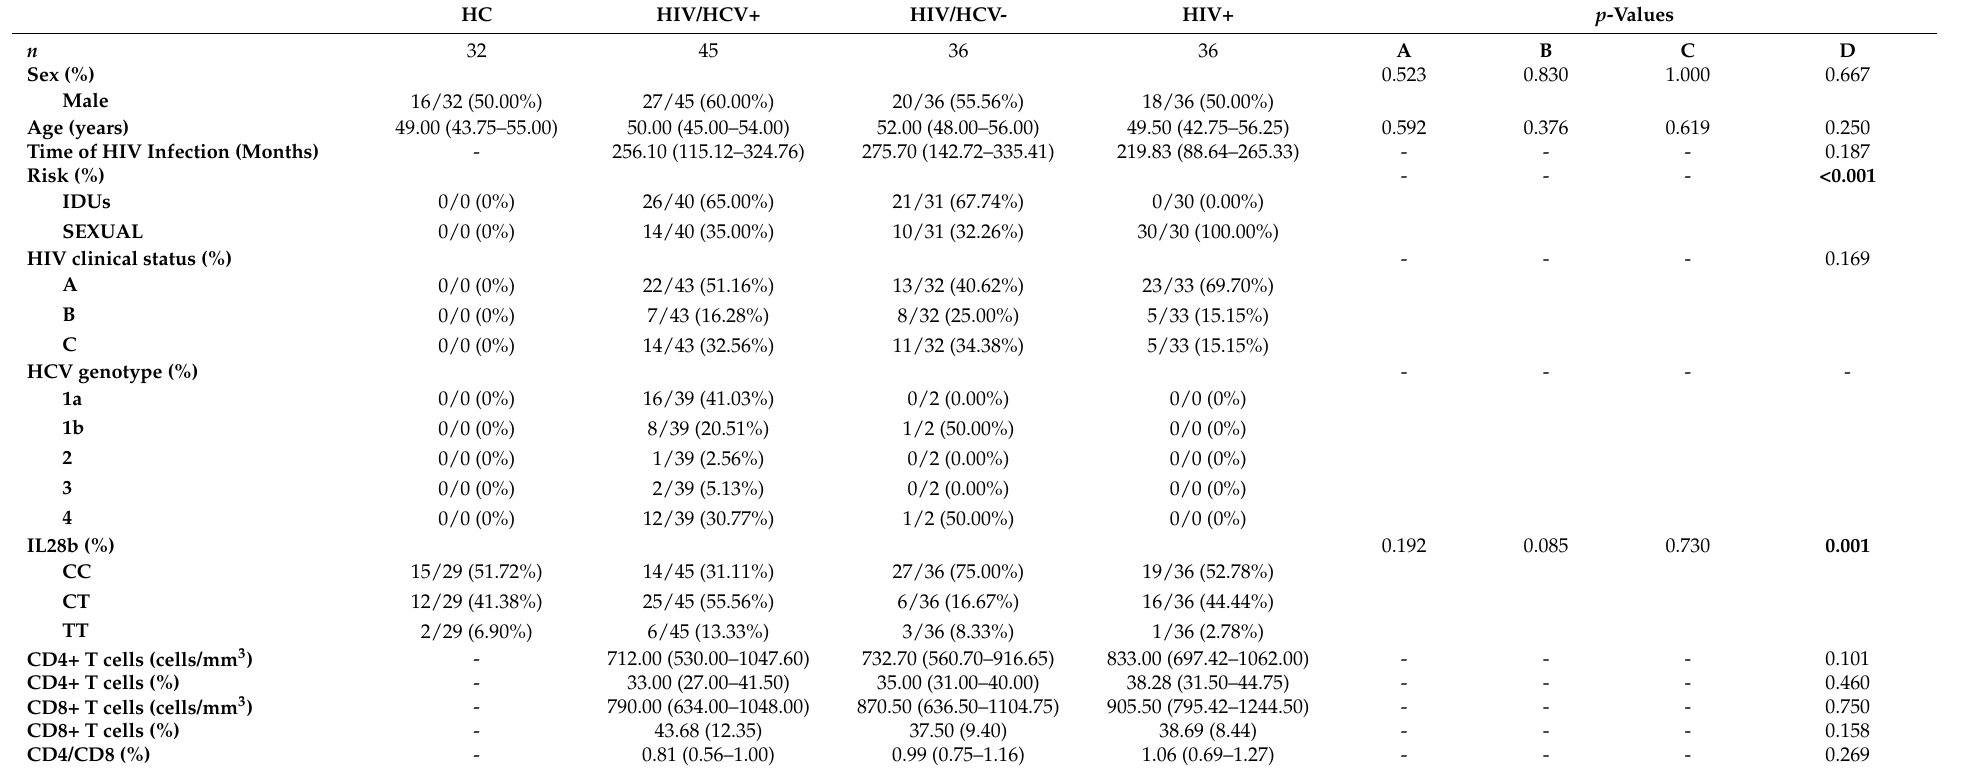
Table 1. Clinical and epidemiological characteristics of the 149 patients enrolled in the study stratified by HCV infection status. Values are expressed as absolute numbers (%) and median (percentile 25 –percentile 75). p -values were estimated with nonparametric Kruskal–Wallis test or Man–Whitney U test for continuous variables and Fisher’s exact test for categorical variables: (A) comparison between HC and HIV/HCV+ groups; (B) comparison between HC and HIV/HCV- groups; (C) comparison between the HC group and HIV+ group; (D) comparison between HIV-1 infected groups. Statistically significant differences are presented in